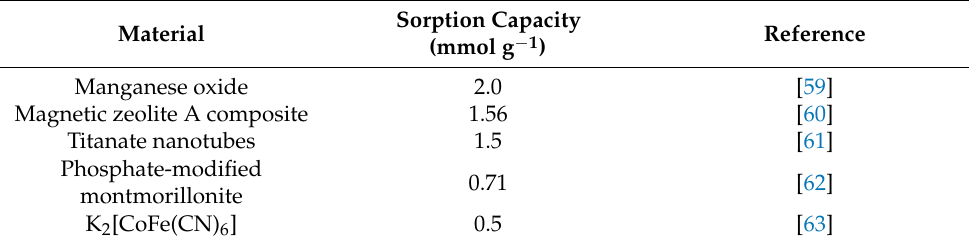
Table 6. Sorption performance of some representative materials toward cesium in aqueous solu- tions.